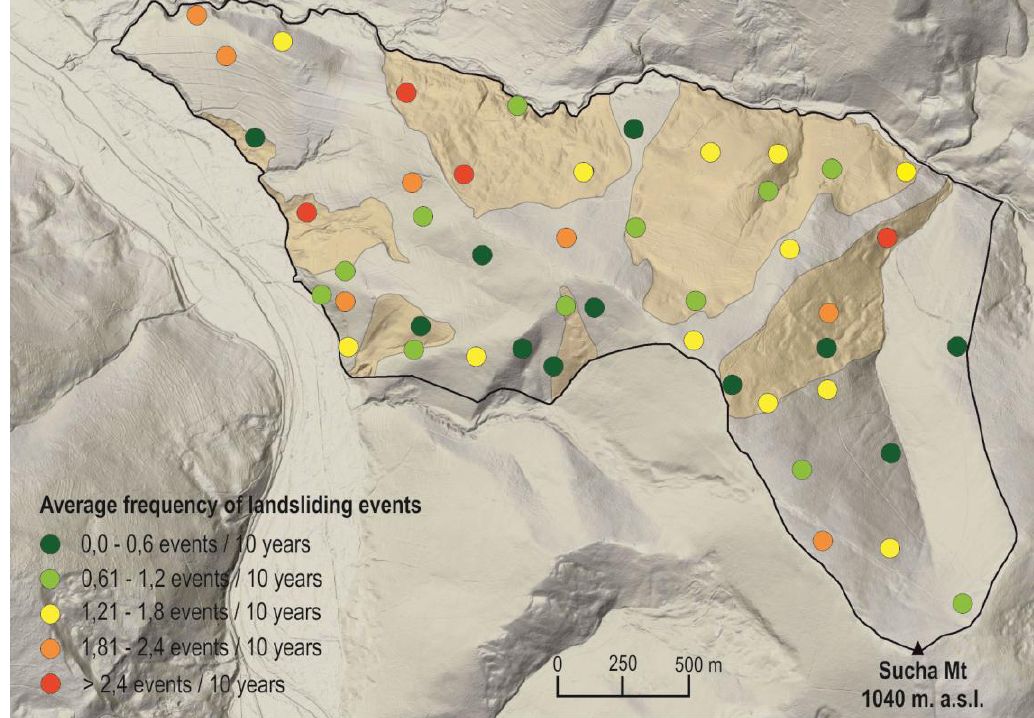
Fig. 4. Average frequency of landslide events dated in each sampling site (shaded relief map based on the DEM from LiDAR data; data source: Central Office for Geodetic and Cartographic Documentation, Poland)